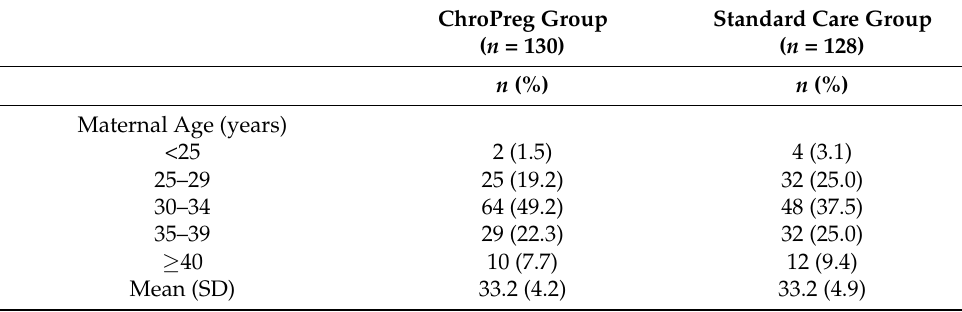
Table 1. Self-reported baseline characteristics of the study population ( n =